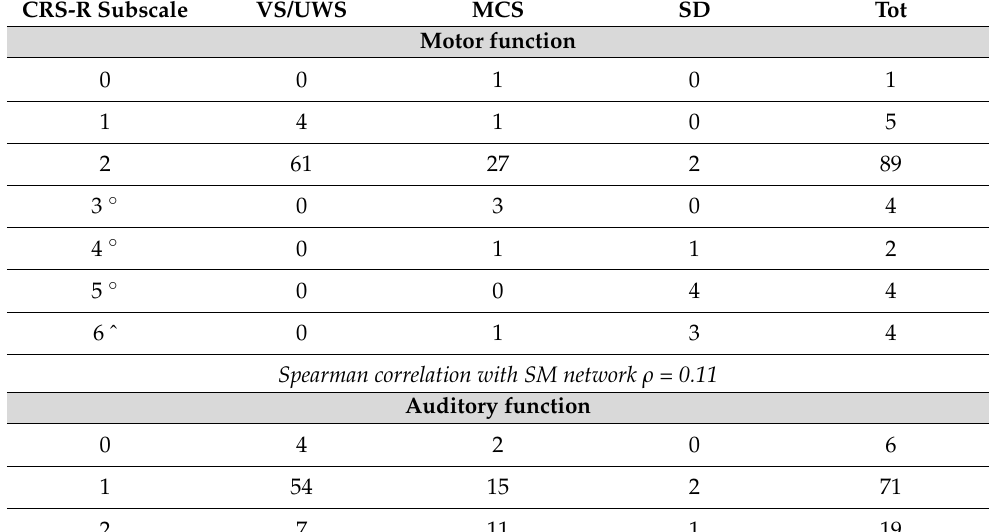
Table 3. Frequency distribution of CRS-R subscale function scores for the different diagnostic categories. CRS-R Subscale VS/UWS MCS SD Tot